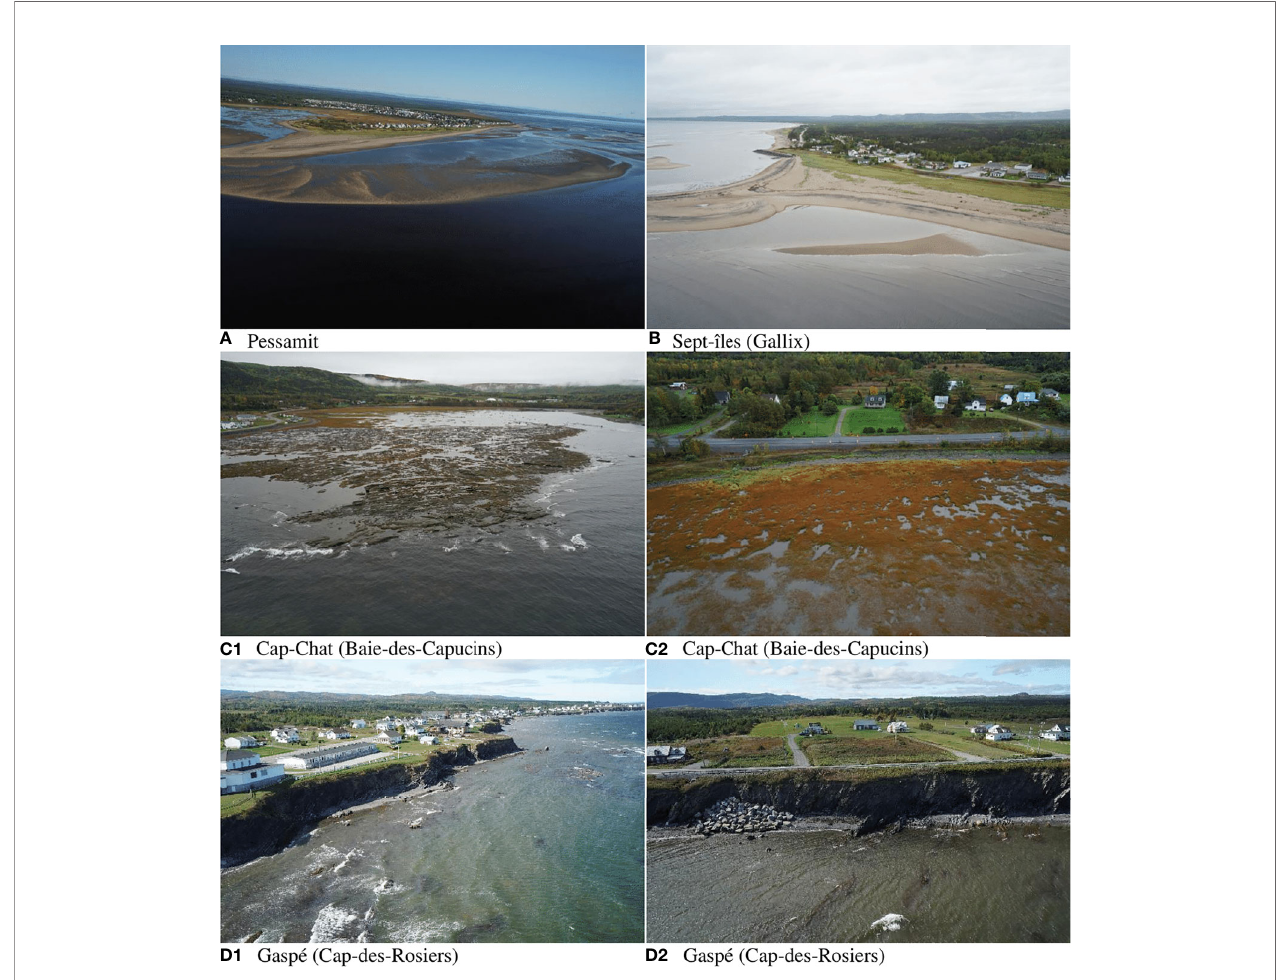
FIGURE 1 | Study sites. (A) Pessamit: indigenous community located on a sandy littoral spit with wide unvegetated sandy foreshore. (B) Sept-I ̂ les (Gallix): sandy beach terrace with a narrow band of sea cabbage characterised by the formation and disappearance of a sandy triangular salient. (C1 , C2) Cap-Chat (Baie-des- Capucins): beach terrace of coarse sand, cobbles and pebbles, fronted by a wide vegetated salt marsh. (D1 , D2) Gaspe ́ (Cap-des-Rosiers): rocky cliff with an unconsolidated top and a lower foreshore of cobbles partially covered by